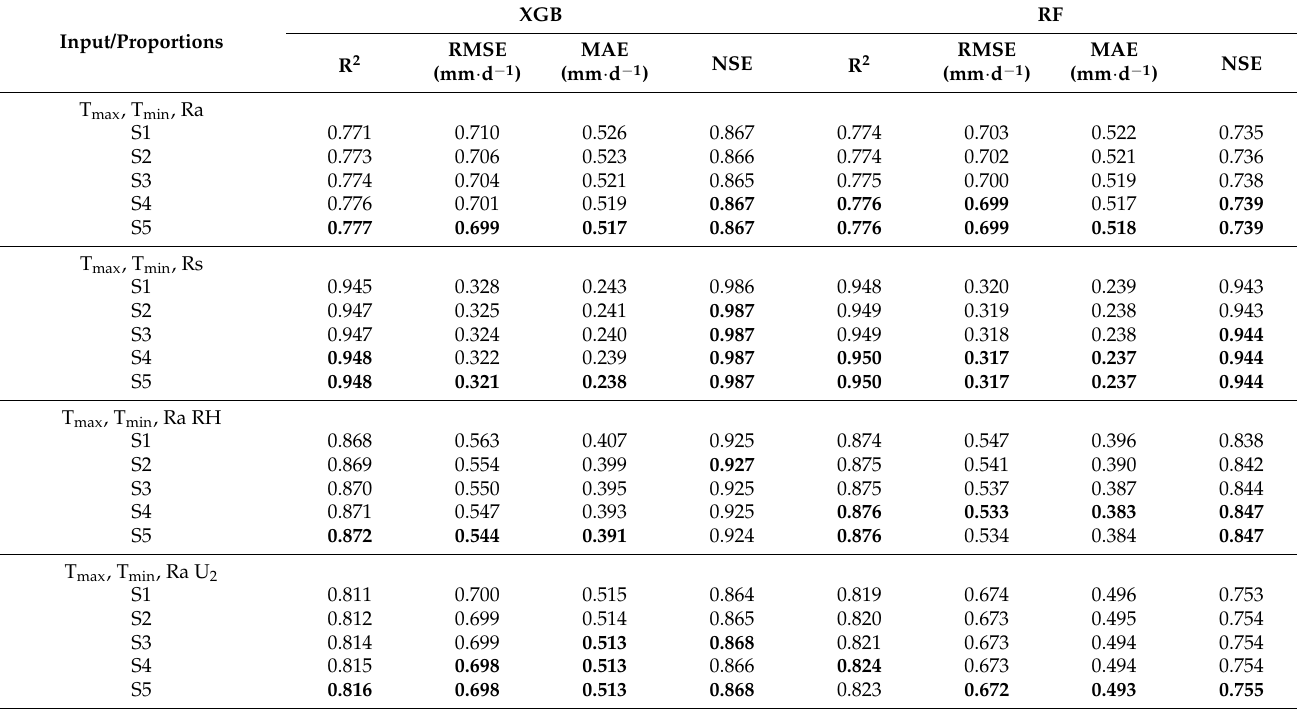
Table 9. Average statistical values of five proportions of different input parameters of two machine learning models in